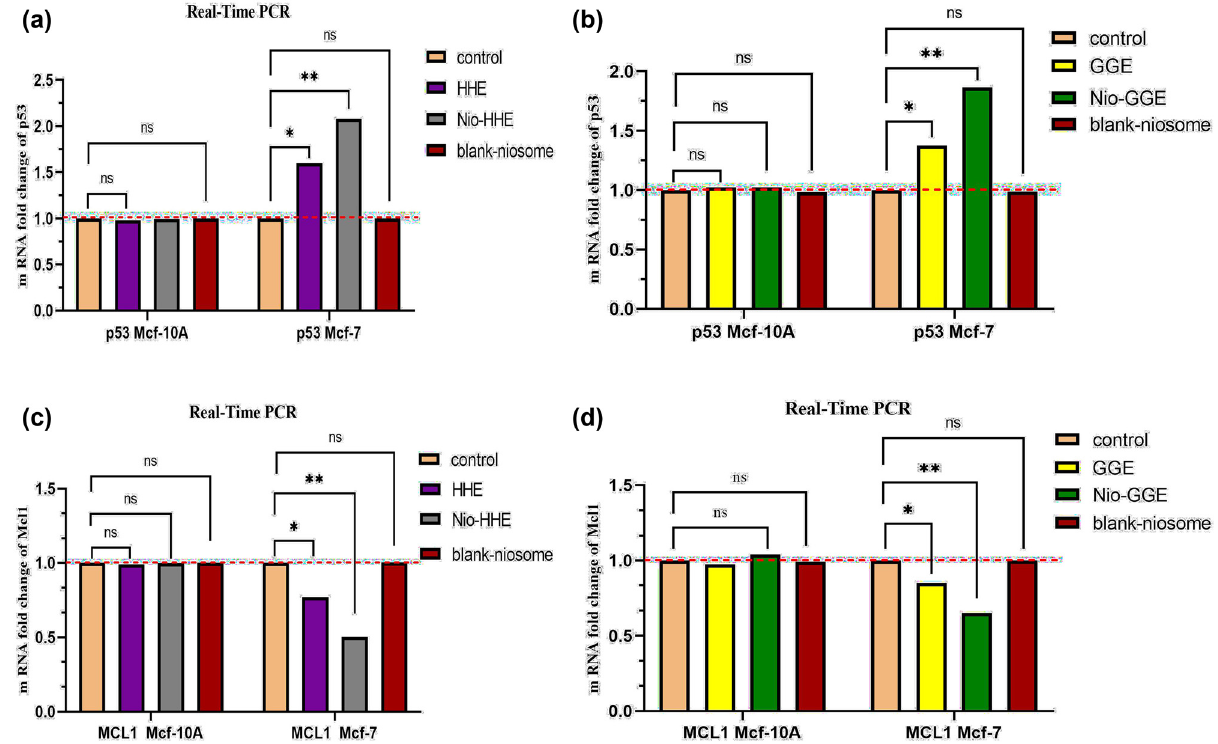
Figure 10: p53 and MCL - 1 gene expression in MCF - 7 cells as cancerous cells and in MCF 10A cells as normal cells. ( a ) Changes in expression of p53 gene after treatment with speci fi c concentration of HHE and Nio - HHE and blank niosome. ( b ) Changes in expression of p53 gene after treatment with speci fi c concentration of GGE and Nio - GGE and blank niosome. ( c ) Changes in expression of MCL - gene after treatment with speci fi c concentration of HHE and Nio - HHE and blank niosome. ( d ) Changes in expression of MCL - 1 gene after treatment with speci fi c concentration of GGE and Nio - GGE and blank niosome; ns: no signi fi cant di ff erence. *, **: P - value <